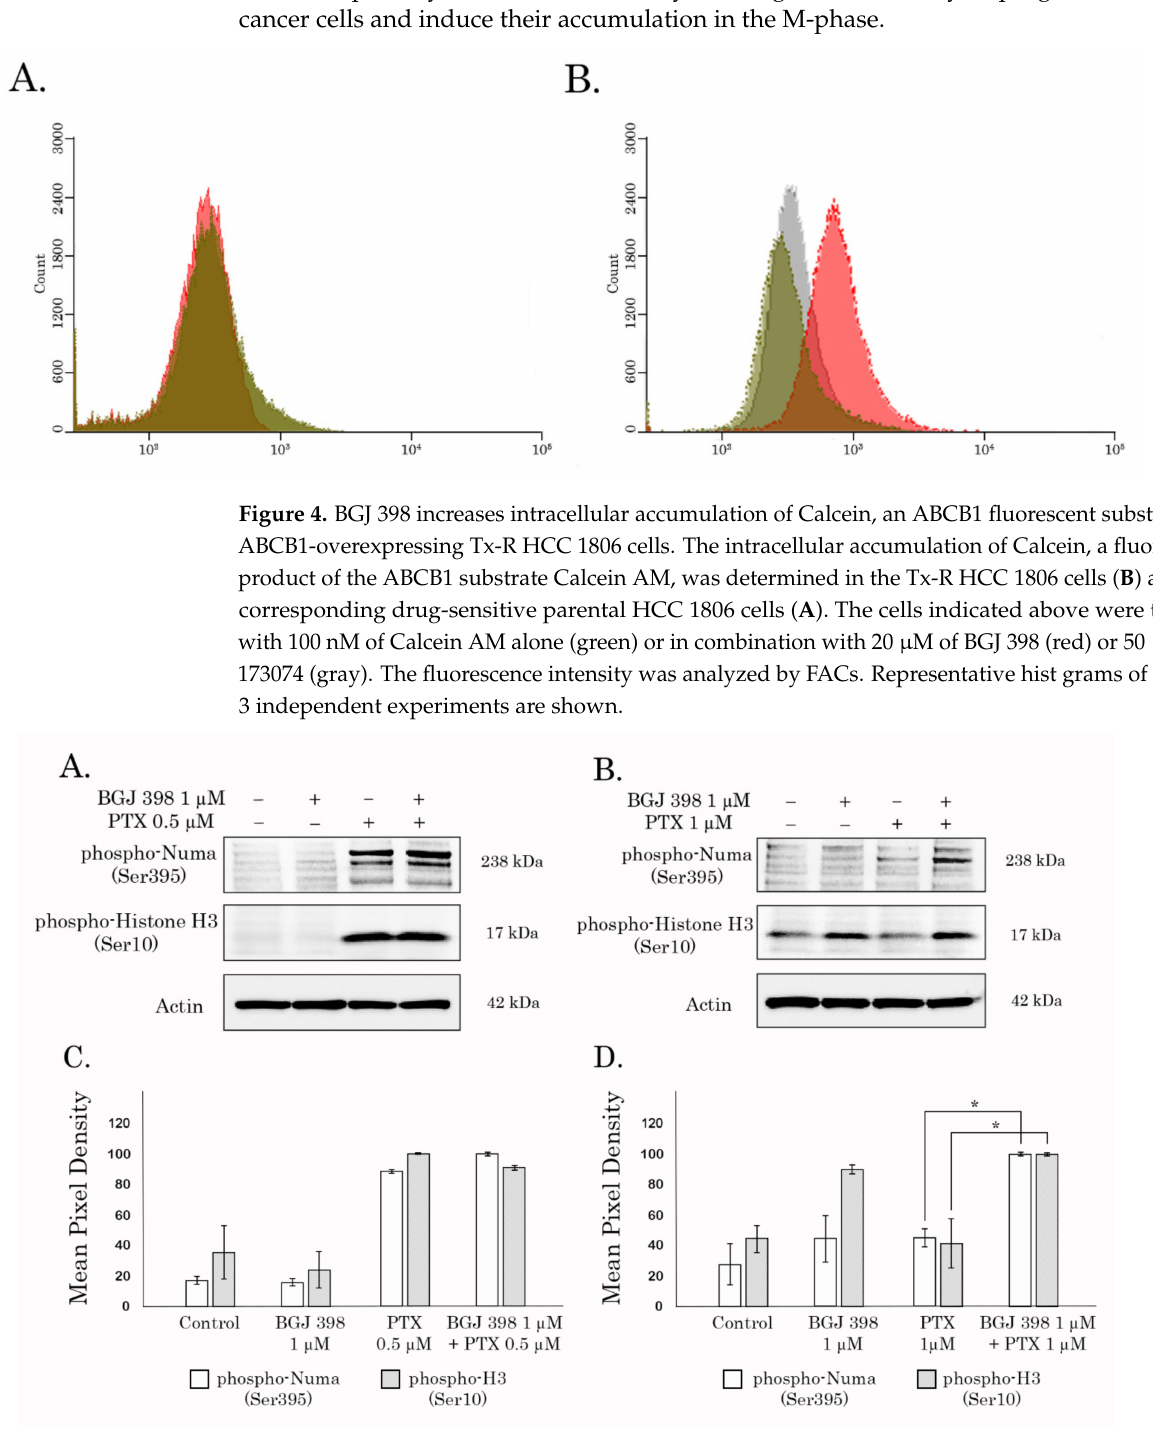
Figure 5. BGJ 398 potentiates accumulation of Tx-R HCC 1806 cancer cells in M-phase after the treatment with PTX. Immunoblot analysis for phospho-NuMA (Ser395) and phospho-H3 (Ser10) in the parental ( A ) and Tx-R ( B ) HCC 1806 breast cancer cells after treatment with DMSO (negative control), BGJ 398, PTX alone or in combination for 48 h. Actin stain is used as a loading control. ( C , D ) Quantification by mean pixel density of pNuMA (Ser395) and pH3 (Ser10) in the parental ( C ) and Tx-R ( D ) HCC 1806 breast cancer cells. Values are means ± SD, n = 3. * p < 0.05 vs. untreated